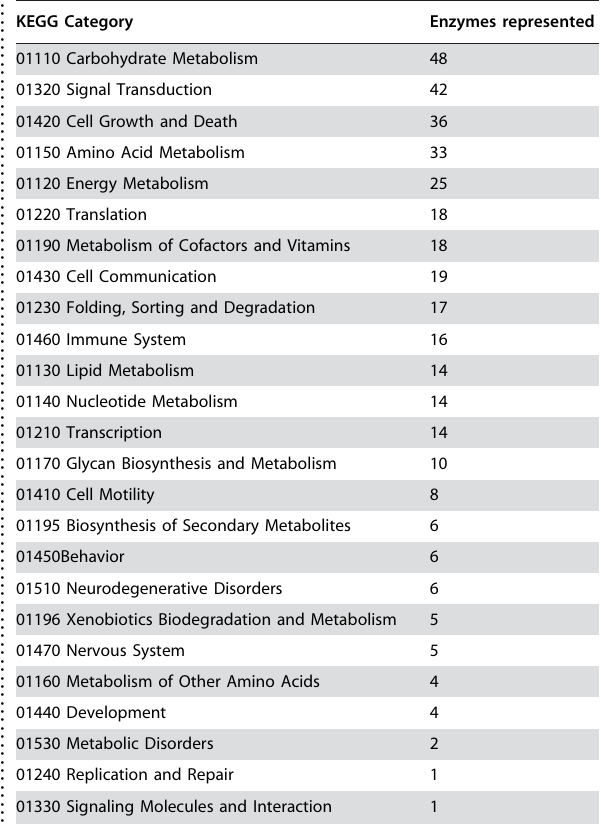
Table 3. Unigene Representation in the Glycolytic Pathway. .. ... .... ... ... .... ... ... .... ... ... .... ... ... .... ... ... .... ... ... .... .